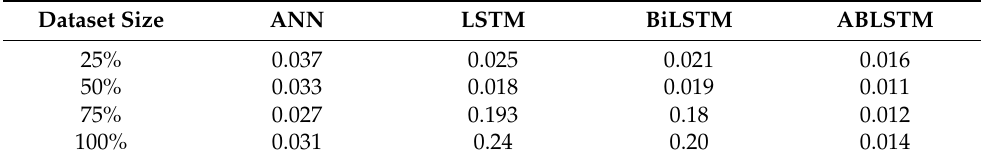
Table 6. Standard Deviation of RUL Prediction Errors.